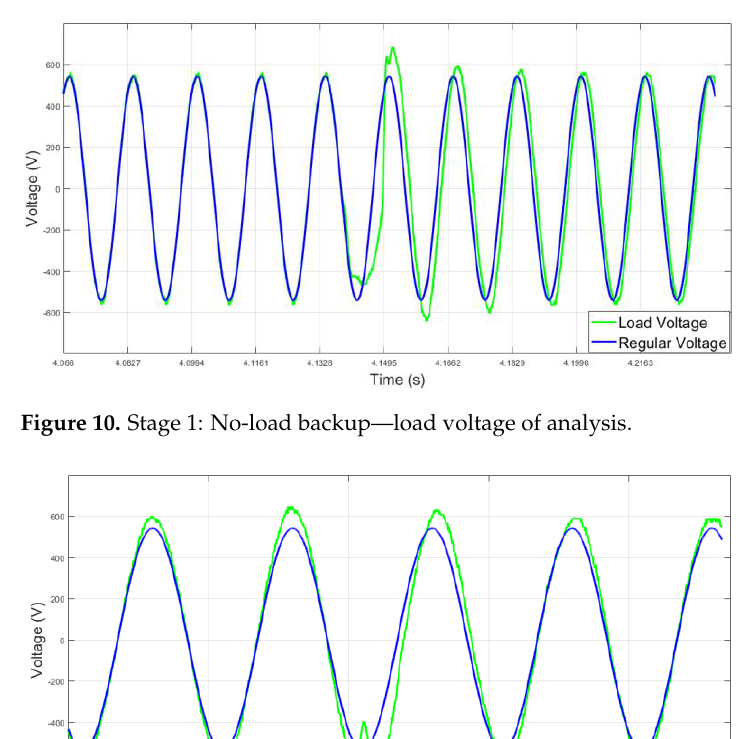
8 of 12 Figure 9. Stage 4: Backup on capacitive loads — signal captured by the oscilloscope at the time the